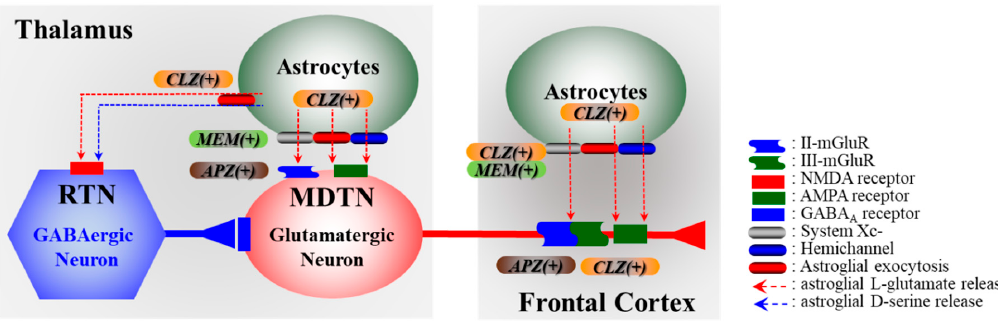
Figure 1. Effects of clozapine (CLZ), aripiprazole (APZ), and memantine (MEM) on glutamatergic transmission in the thalamocortical pathway from the mediodorsal thalamic nucleus (MDTN) to the frontal cortex. Glutamatergic neurons in the MDTN receive GABAergic inhibition from the reticular thalamic nucleus (RTN). Glutamatergic neurons in the MDTN also receive inhibitory and excitatory tripartite synaptic transmission via group II metabotropic glutamate receptors (II-mGluR) and glutamate/ α -amino-3-hydroxy-5-methyl-4-isoxazolepropionic acid receptors (AMPAR), respectively. Astrocytes release L-glutamate through the transporter (system Xc-), hemichannel, and exocytosis mechanisms. Astrocytes also release D-serine via an activated astroglial exocytosis mechanism. The combination of astroglial-released L-glutamate and D-serine enhances the glutamate/N-methyl-D-aspartate receptor (NMDAR). L-glutamate output through system Xc- activates II-mGluR and III-mGluR in the thalamus and frontal cortex. The output of L-glutamate through the hemichannel activates AMPAR in the thalamus.